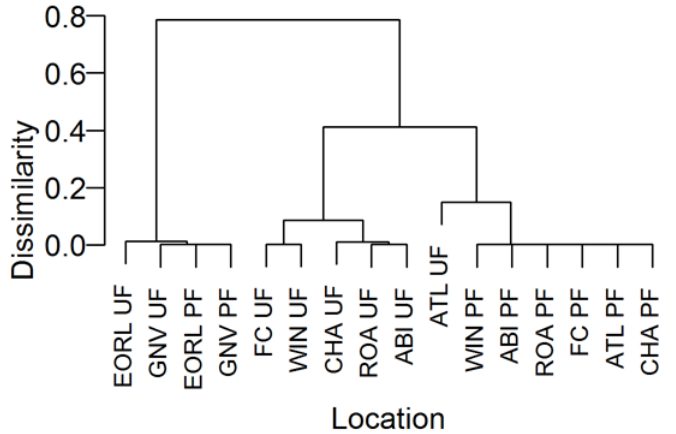
Figure 7. Cluster dendrogram grouping locations based on their similarities in species composition via the Raup-Crick Dissimilarity index. PF = Periurban Forest, UF = Urban Forest, ATL = Atlanta, GA; CHA = Charlottesville, VA; EORL = East Orlando, FL; FC = Falls Church, VA; GNV = Gainesville, FL; ROA = Roanoke, VA; ABI = Abingdon, VA; WIN = Winchester, VA.